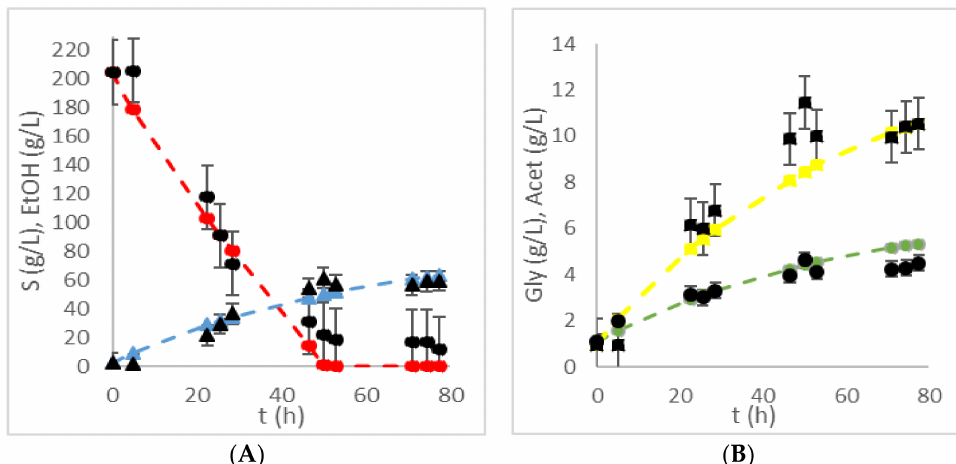
Figure 2. Comparison between experimental (no line) and model values (dashed line) for ( A ) substrate ( • ) and ethanol ( (cid:78) ) concentration and ( B ) glycerol ( (cid:4) ) and acetic acid ( • ) concen- tration obtained for experiment with interval HRTB rotation mode (12 min; 10 rpm). Discrepancies between experimental data are presented as error